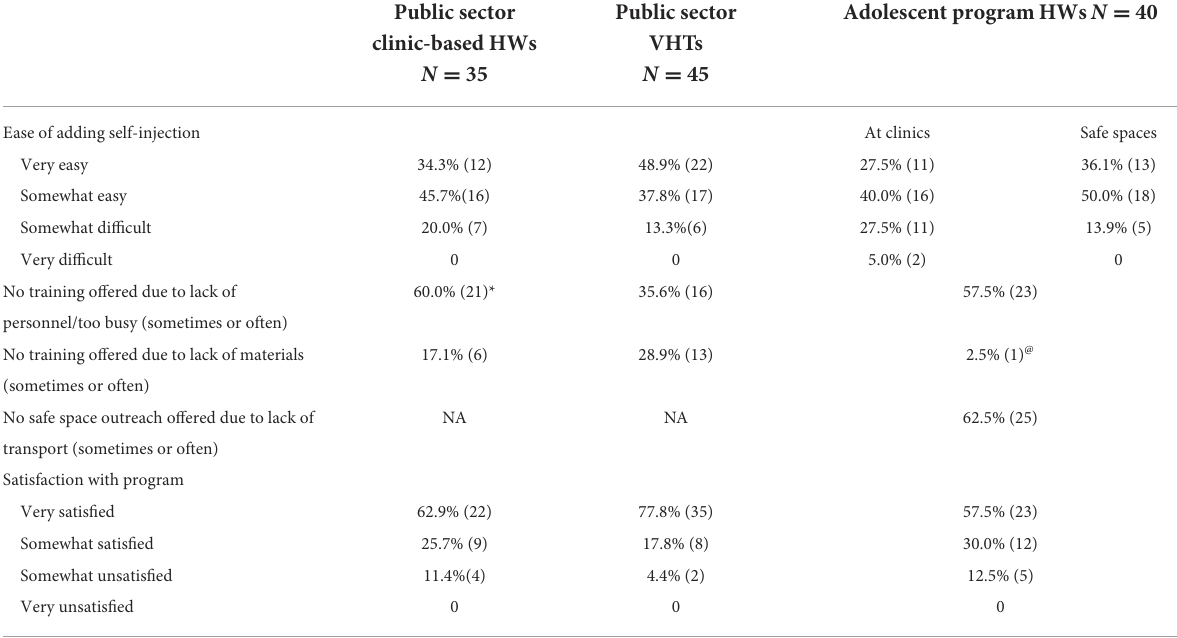
TABLE 4 Health worker perceptions of the self-injection program